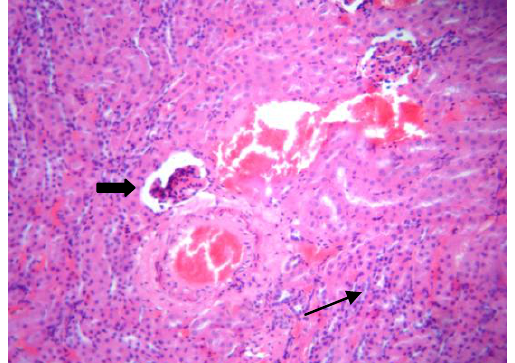
Fig (17):kidney atday 3 pi. showed hyper cellularty of the glomerli ( ) with moderate hyperplasia of the endothelial lining of the capillaries between renal tubules ( ) ( H&EX40).